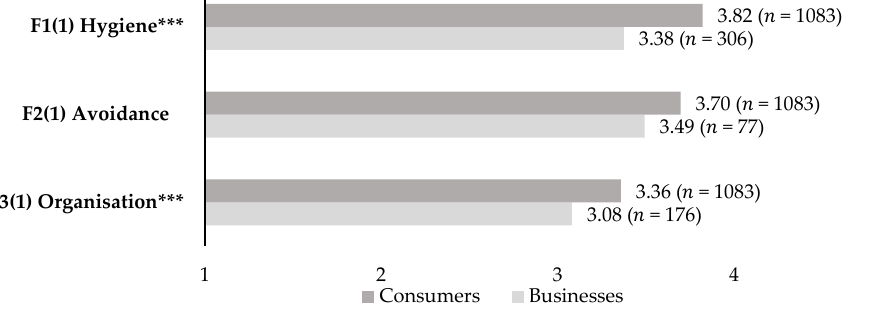
Table 4. Coefficient estimates and diagnostics from hierarchical binary logistic regression explain- ing consumers’ revisit intentions (study 1; 𝑛 = 1053).